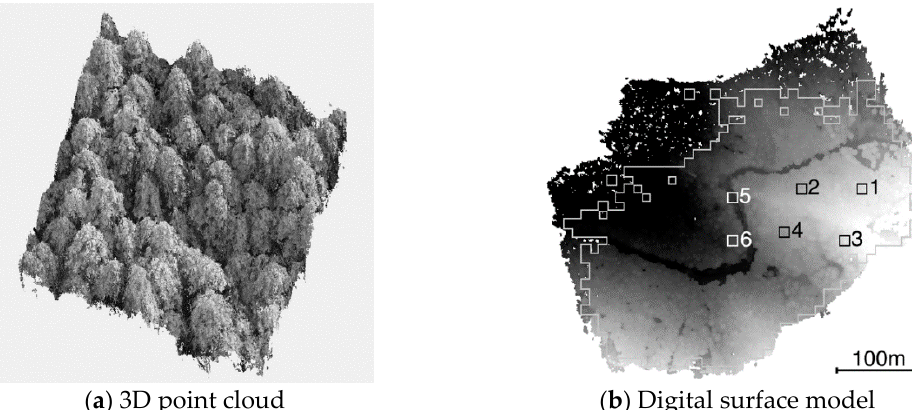
Figure 5. ( a ) Three-dimensional (3D) point cloud of the cedar forest canopy generated by SfM. The area corresponds 30 × 30 m 2 . ( b ) A digital surface model of the site with 0.5-m resolution. Heights from 750 to 860 m were assigned values of 0 to 255, respectively, in the digital image. Locations of six Sentinel-2 sample pixels are shown.